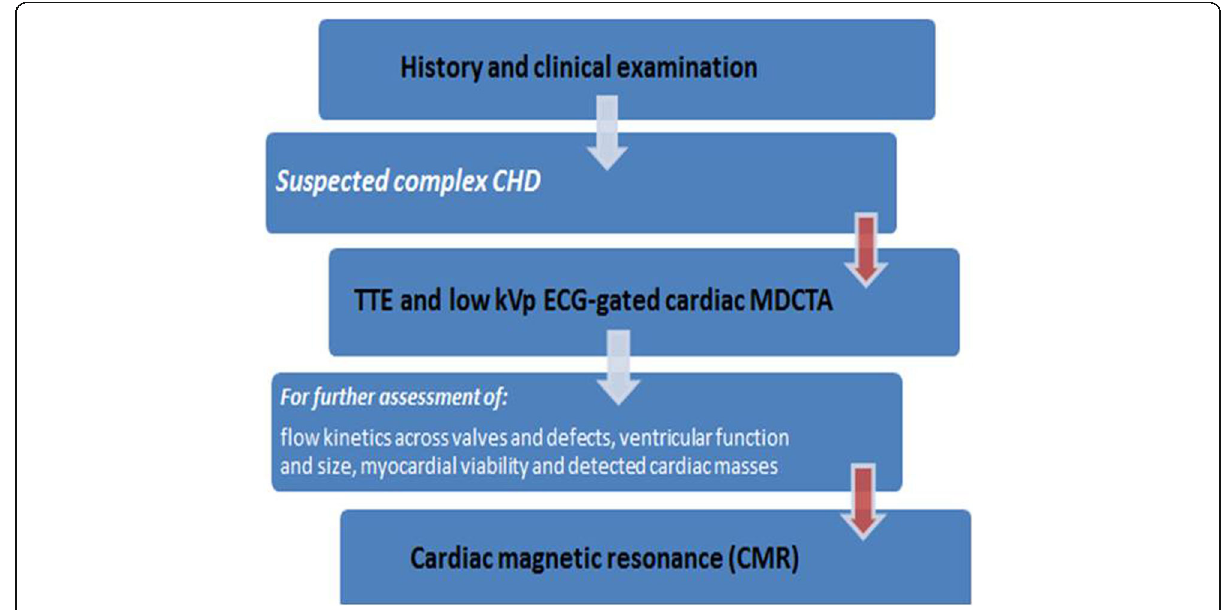
Fig. 4 Preoperative diagnostic algorithm for complex CHD